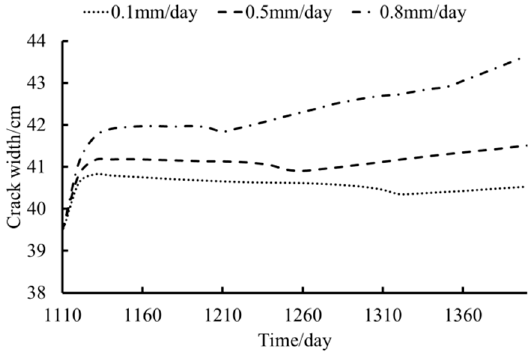
infiltration rate of 0.8 mm/day.